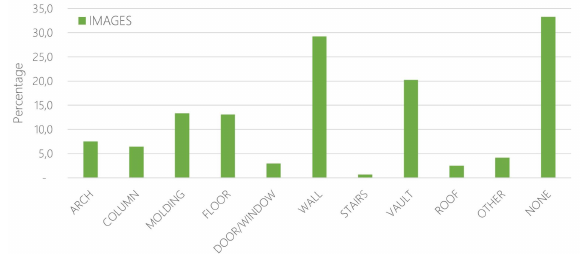
Figure 11 . Distribution of the classes in the images.